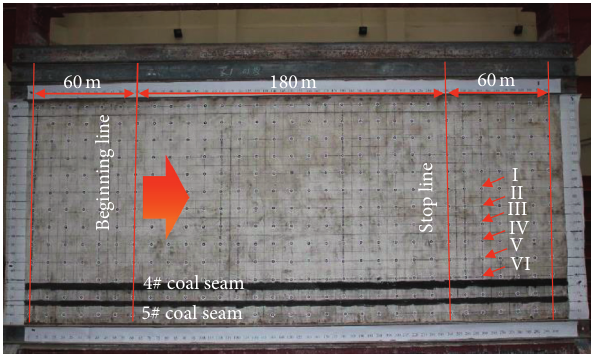
Figure 2: Model for similar simulation test.